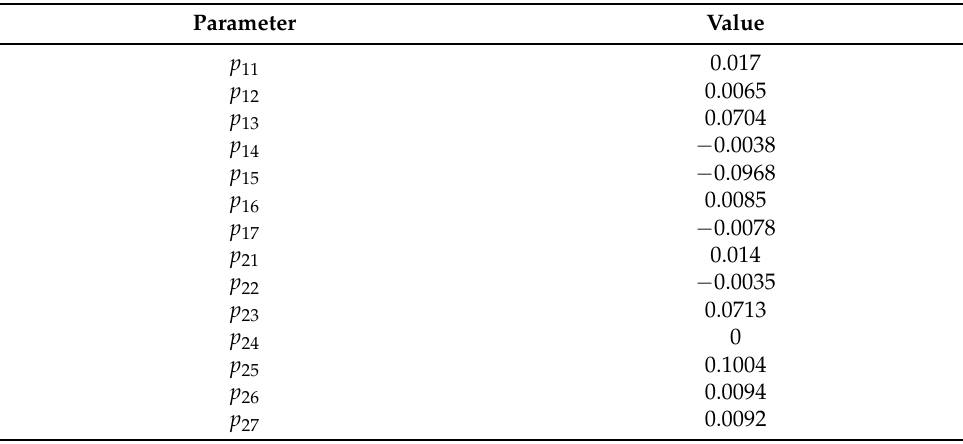
Table A3. Friction characteristic model parameters.